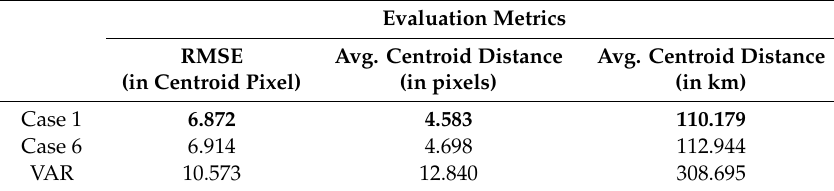
Table 8. Comparison results of Case 1, Case 6 and VAR.